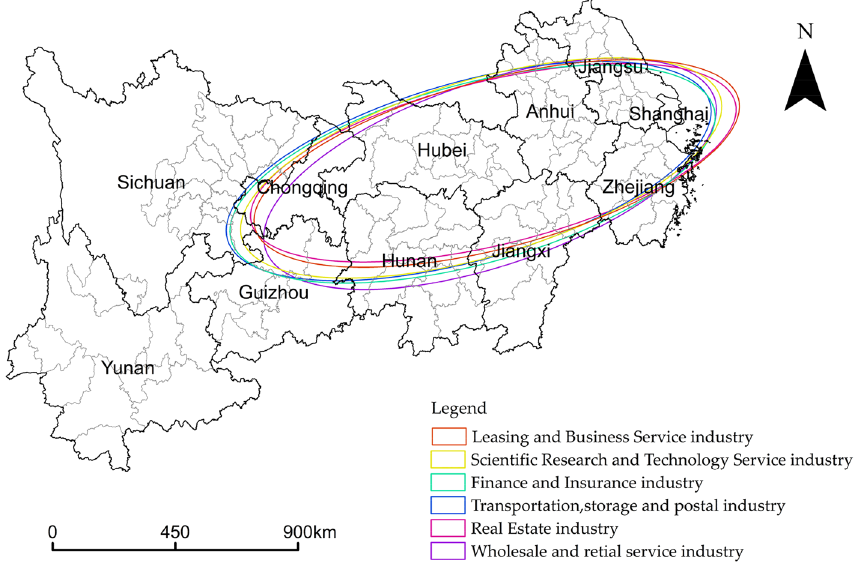
Figure 4. Standard deviation ellipse of producer